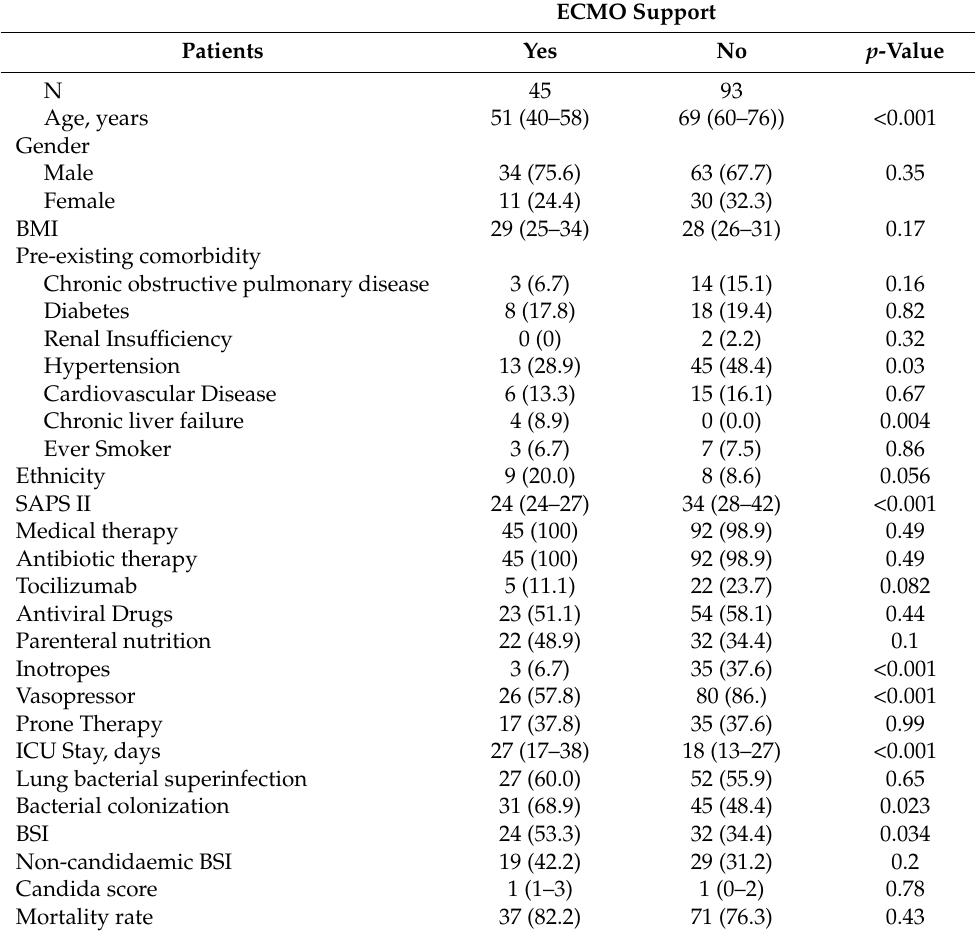
Table 1. Characteristics of patients admitted to the intensive care unit of Umberto I teaching hospital of Rome between March 2020 and June 2021 and who underwent IOT and mechanical ventilation. Results are expressed as number (percentage) or median (interquartile range).